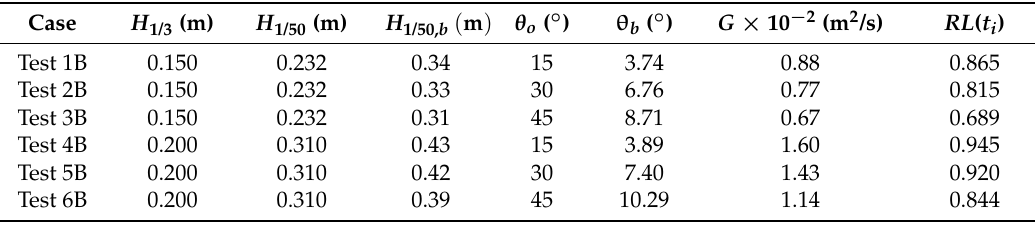
Table 5. GSb simulated cases to investigate beach resilience associated to the groin removal. The initial condition for all simulations corresponds to the shoreline position for Test 6A at t = 720 h. θ o is the deep-water wave